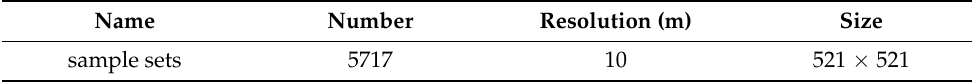
Table 1. The parameter of sample sets.